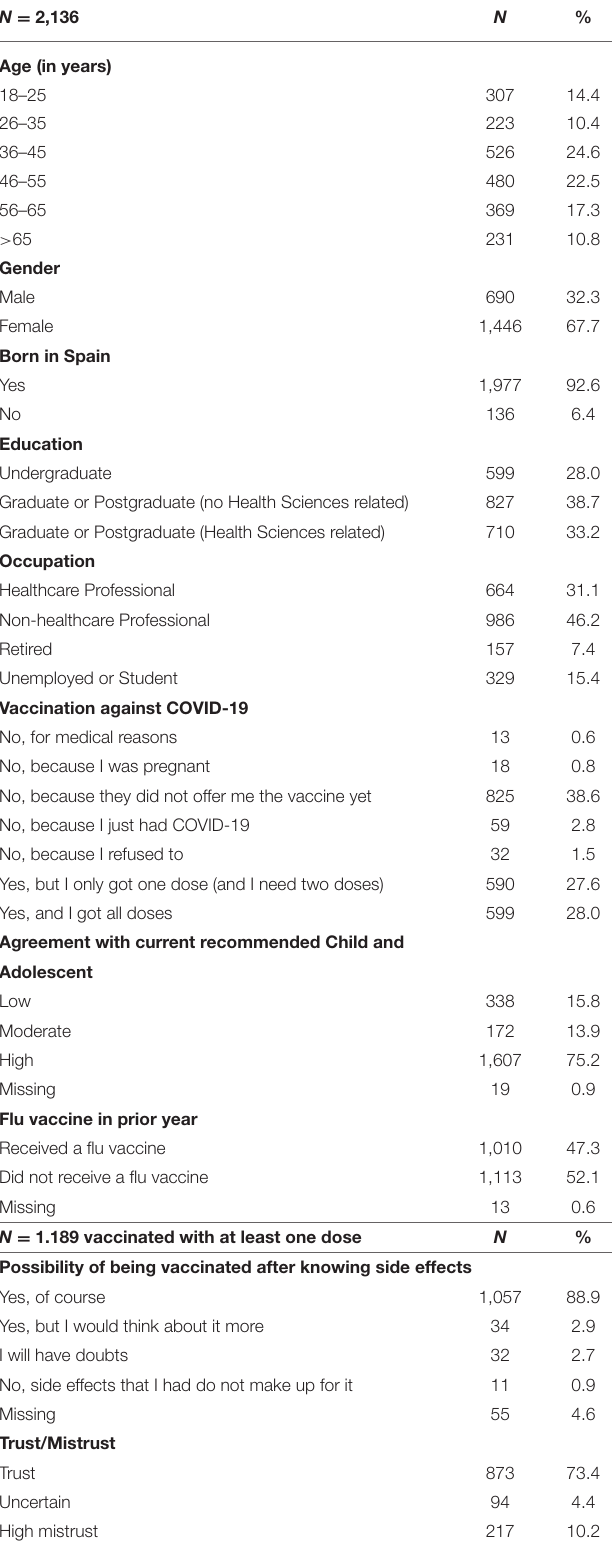
TABLE 1 | Sample characteristics ( N =